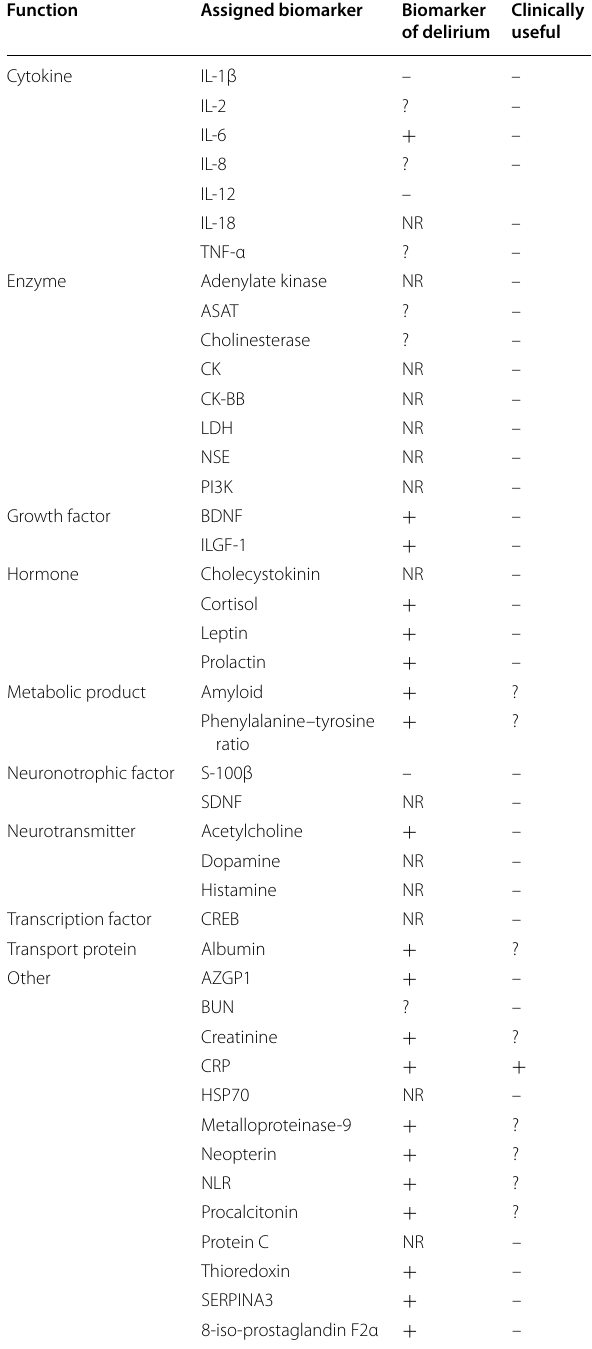
Table 3 Role of suggested biomarkers of delirium according to literature